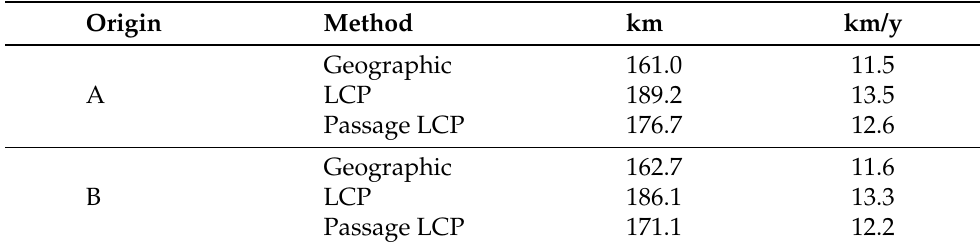
Table 2. Estimates of R. nitidula expansion rate based on distances between the two origins (2006) and the most distant recent occurrences (2020) calculated with three methods.